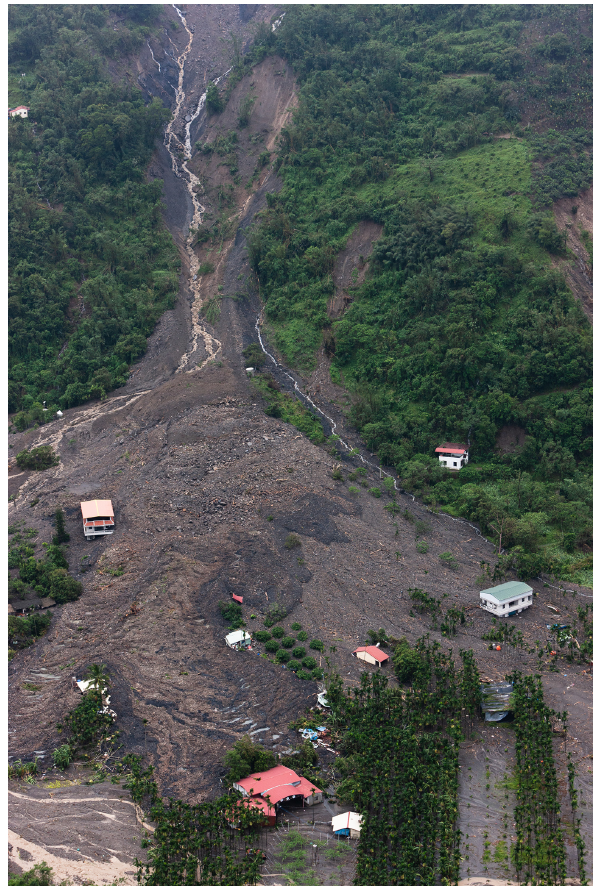
Figure 1. Aerial view of the debris flow deposit formed at Xinfa, southern Taiwan, during Typhoon Morakot in August 2009 (Photo- graph by Chi Po-lin. Provided by Chi Po-lin Foundation© Above Taiwan Cinema, Inc. Only authorized for this article and cannot be extracted, distributed, or reproduced separately in any form. Offend- ers shall be prosecuted for legal responsibility by relevant laws and